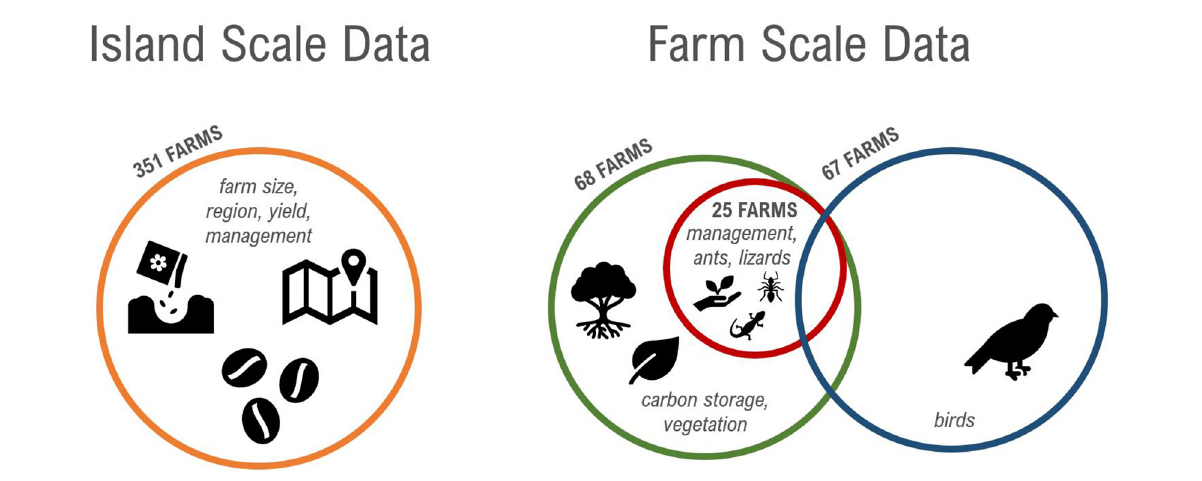
FIGURE1 Graphic showing overlap of datasets used in this study. Island scale data came from the USDA dataset of 352 coffee farms across Puerto Rico and included data only on farm size, region, yield, and management (discreet measures). Farm scale data was pieced together from three existing datasets from different studies and included data on carbon storage, vegetation, ants, lizards, birds, and management (continuous measures). These datasets overlapped for some farms, but not